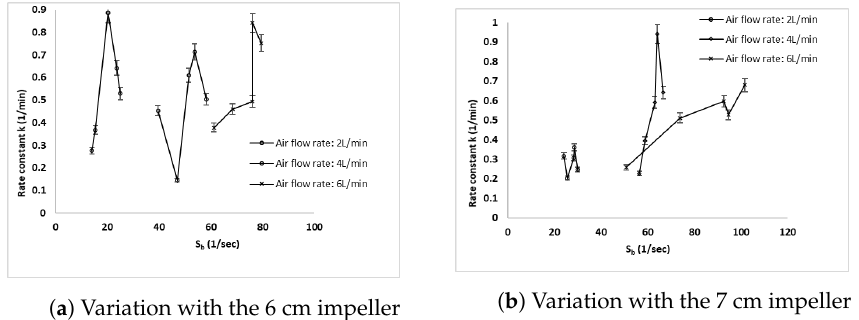
Figure 16. Nickel flotation rate constant vs. the bubble surface area flux with different diameter impellers where ( a ) shows variation with 6 cm impeller and ( b ) shows variation with 7 cm